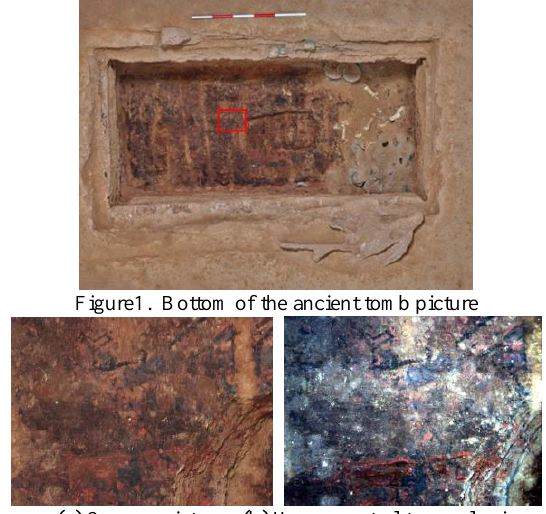
(a) Camera picture (b) Hyperspectral true-color image Figure2. Experimental